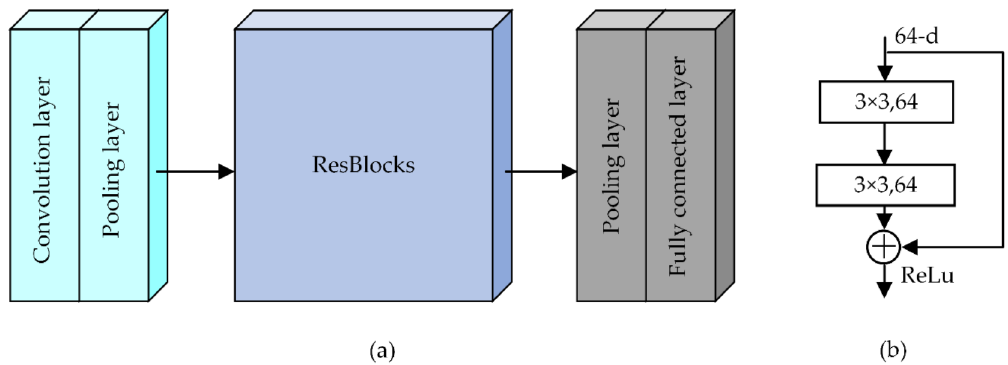
Figure 8. ( a ) Basic architecture of a 2D CNN; ( b ) the structure of the